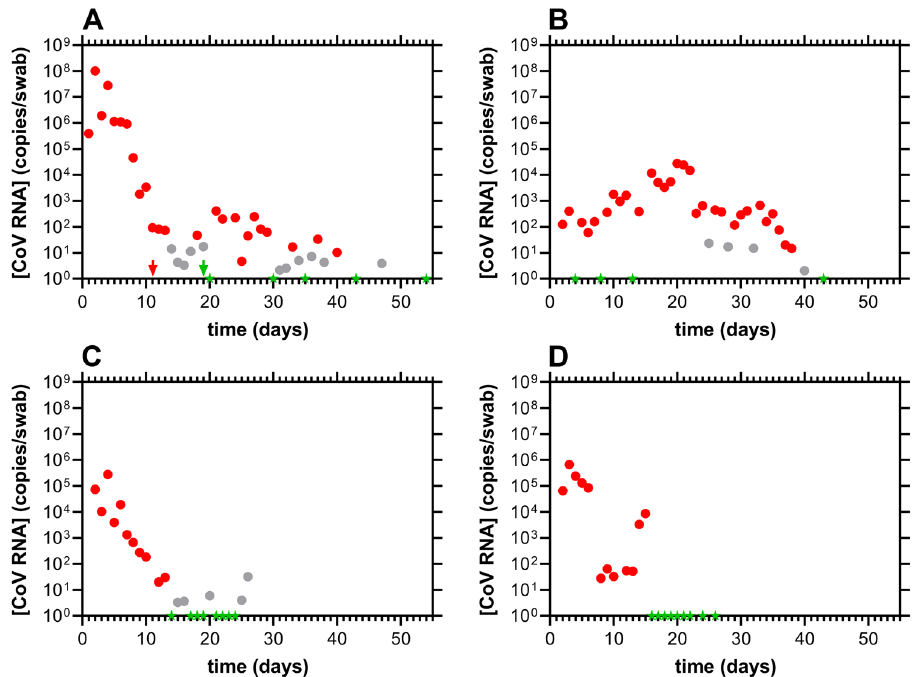
Fig. 2 Longitudinal viral load kinetics for subject 21 across multiple anatomic compartments. Red, positive; gray, inconclusive (i.e., only one of the two oligonucleotide probes targeting the viral nucleocapsid protein gene transcript fragment met the assay threshold for positivity); green, negative (i.e., both viral probes led to C t values above 40, but the human gene transcript control had a C t value below 40. These consist of valid samples where the SARS- CoV-2 content was below the limit of quantitation of the assay); arrows designate clinical RT-qPCR test results (i.e., from separate, CLIA laboratory, outside of current clinical study); the axis ranges are the same across all four panels for ease of comparison. A nasal swab viral RNA copy dynamics; B